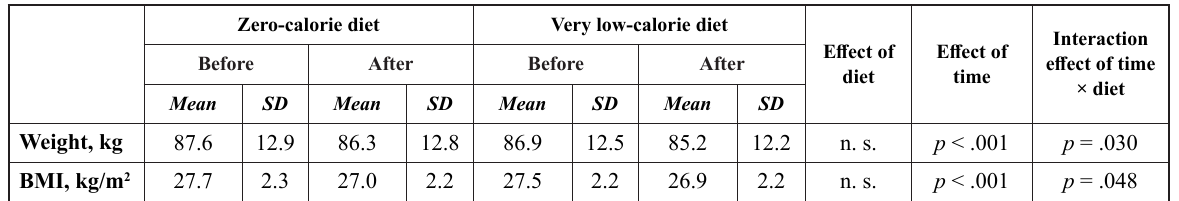
were observed for anthropometric data. Participants in the zero-calorie diet and very low-calorie diet lost ( p < .001) 2.2 ± 0.9 kg and 1.7 ± 0.8 kg of initial weight, and 0.7 ± 0.3 kg/m 2 and 0.5 ±